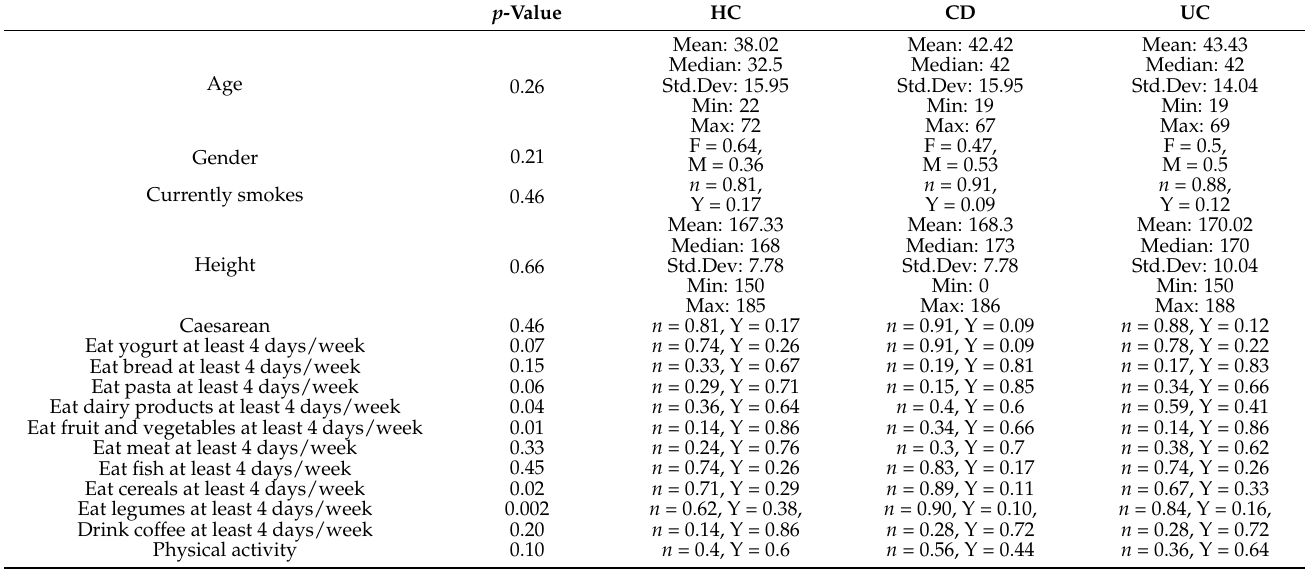
Table A1. Demographic and habit-related parameters of the cohort. The p -values refer to the Kruskall– Wallis test and Fisher’s test between IBD and the numerical or categorical variables, respectively. n = no, Y = yes. The variables in bold were significantly unbalanced between the HC (42 samples), CD (52 samples) and UC (58 samples)